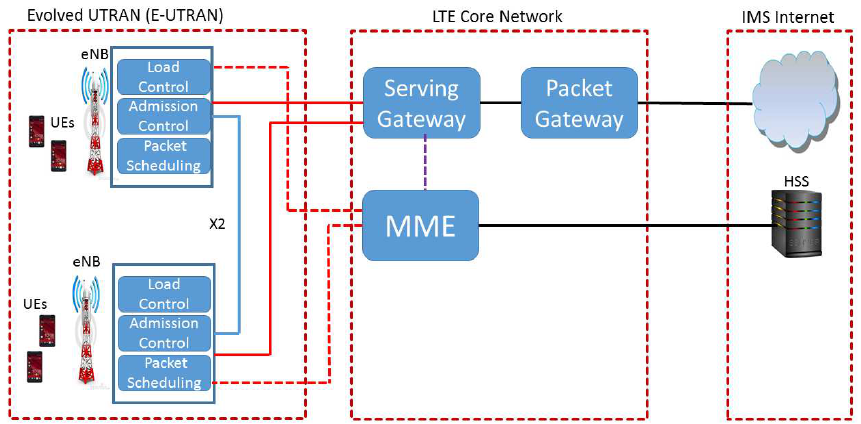
Figure 2. LTE network architecture.